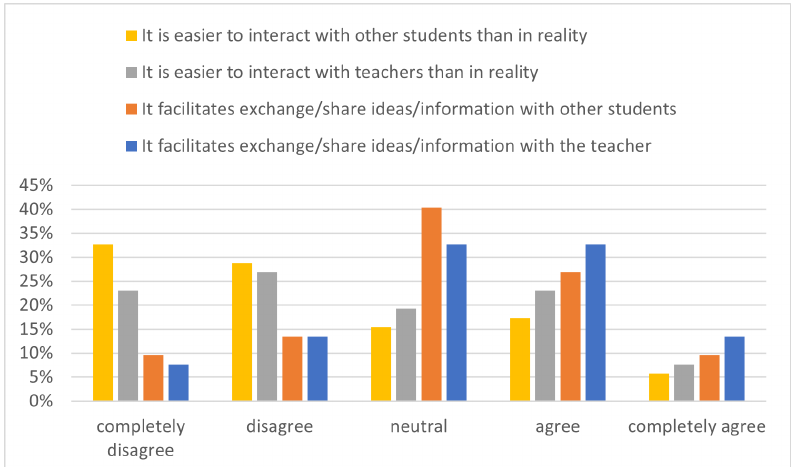
Figure 9. Survey results for